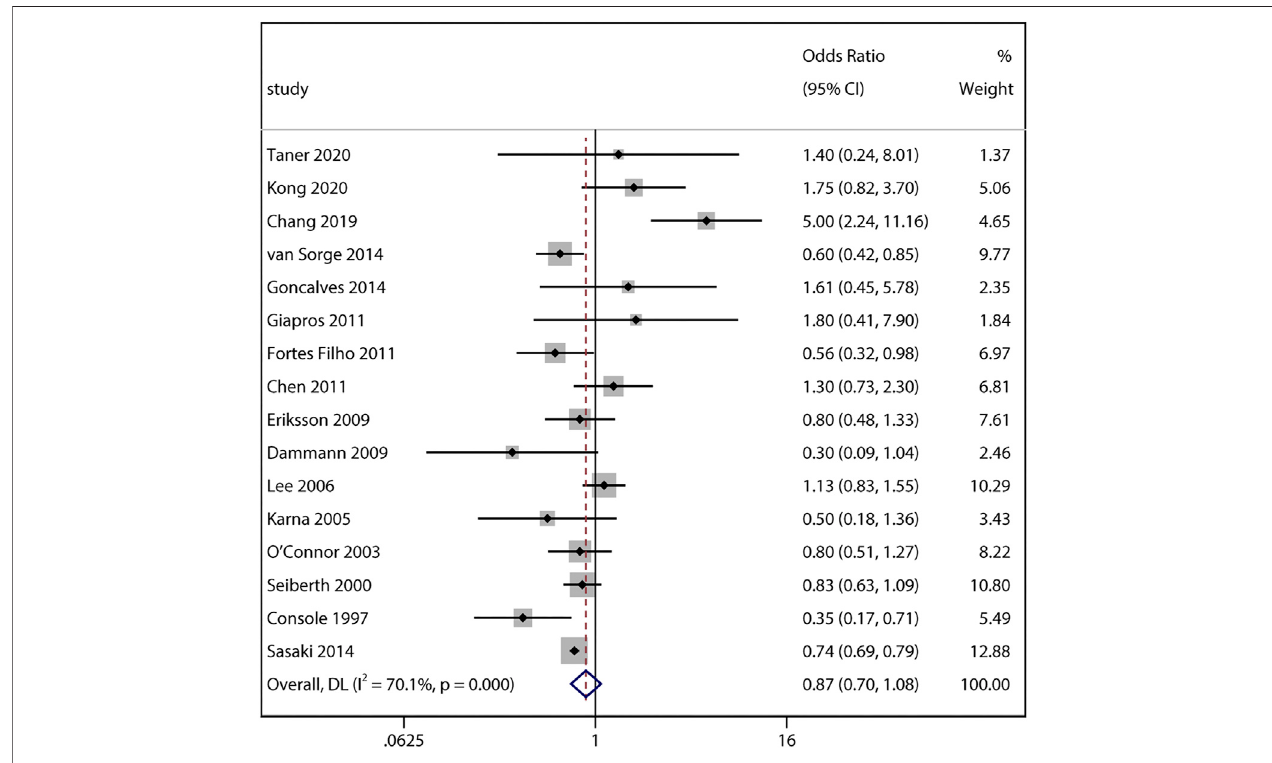
FIGURE 3 | Meta-analysis of adjusted ORs and 95% CIs for the association between antenatal corticosteroids exposure and any stage of retinopathy of prematurity.